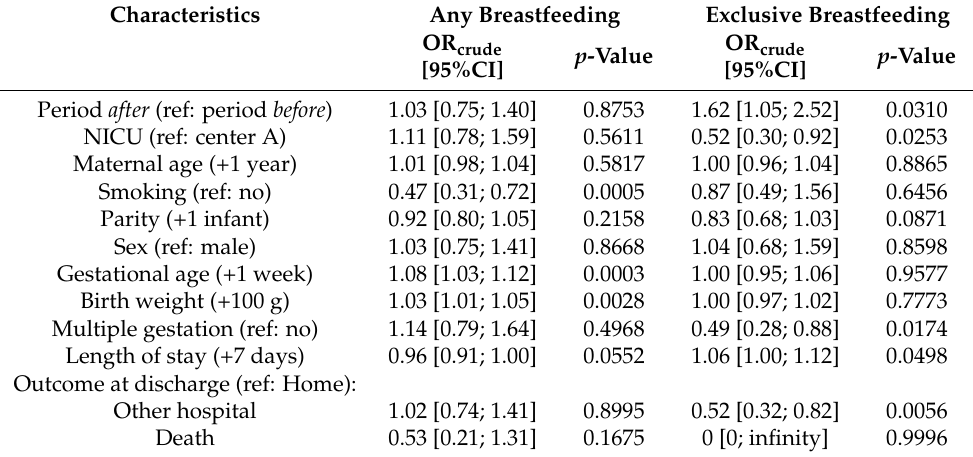
Table 2. Perinatal characteristics associated with breastfeeding and exclusive breastfeeding at dis- charge (univariate analysis). Characteristics Any